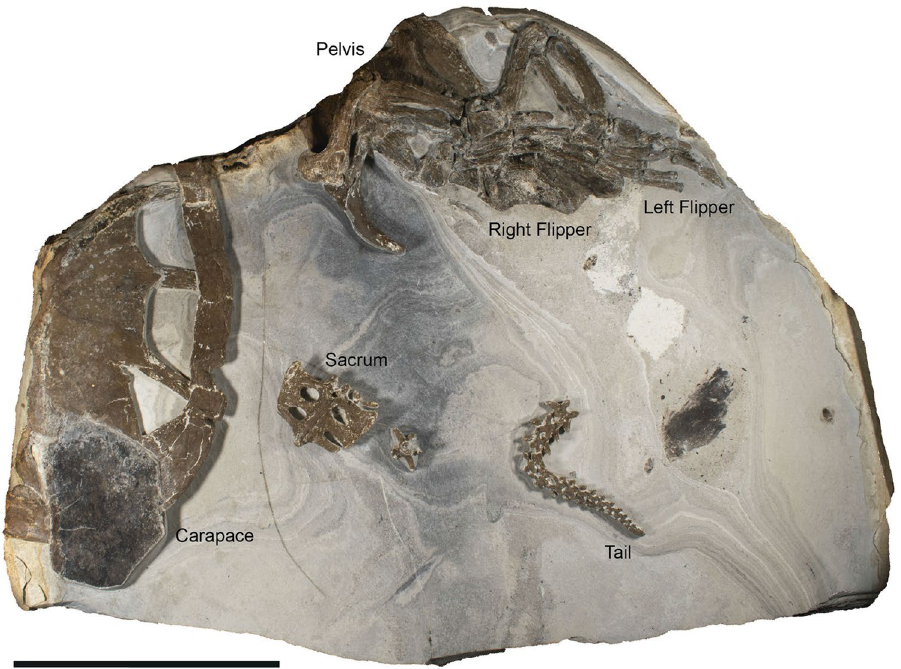
Figure 1. Photograph of DK 807, Pan-Cheloniidae indet., from the earliest Eocene Fur Formation of Denmark. Scale bar, 20